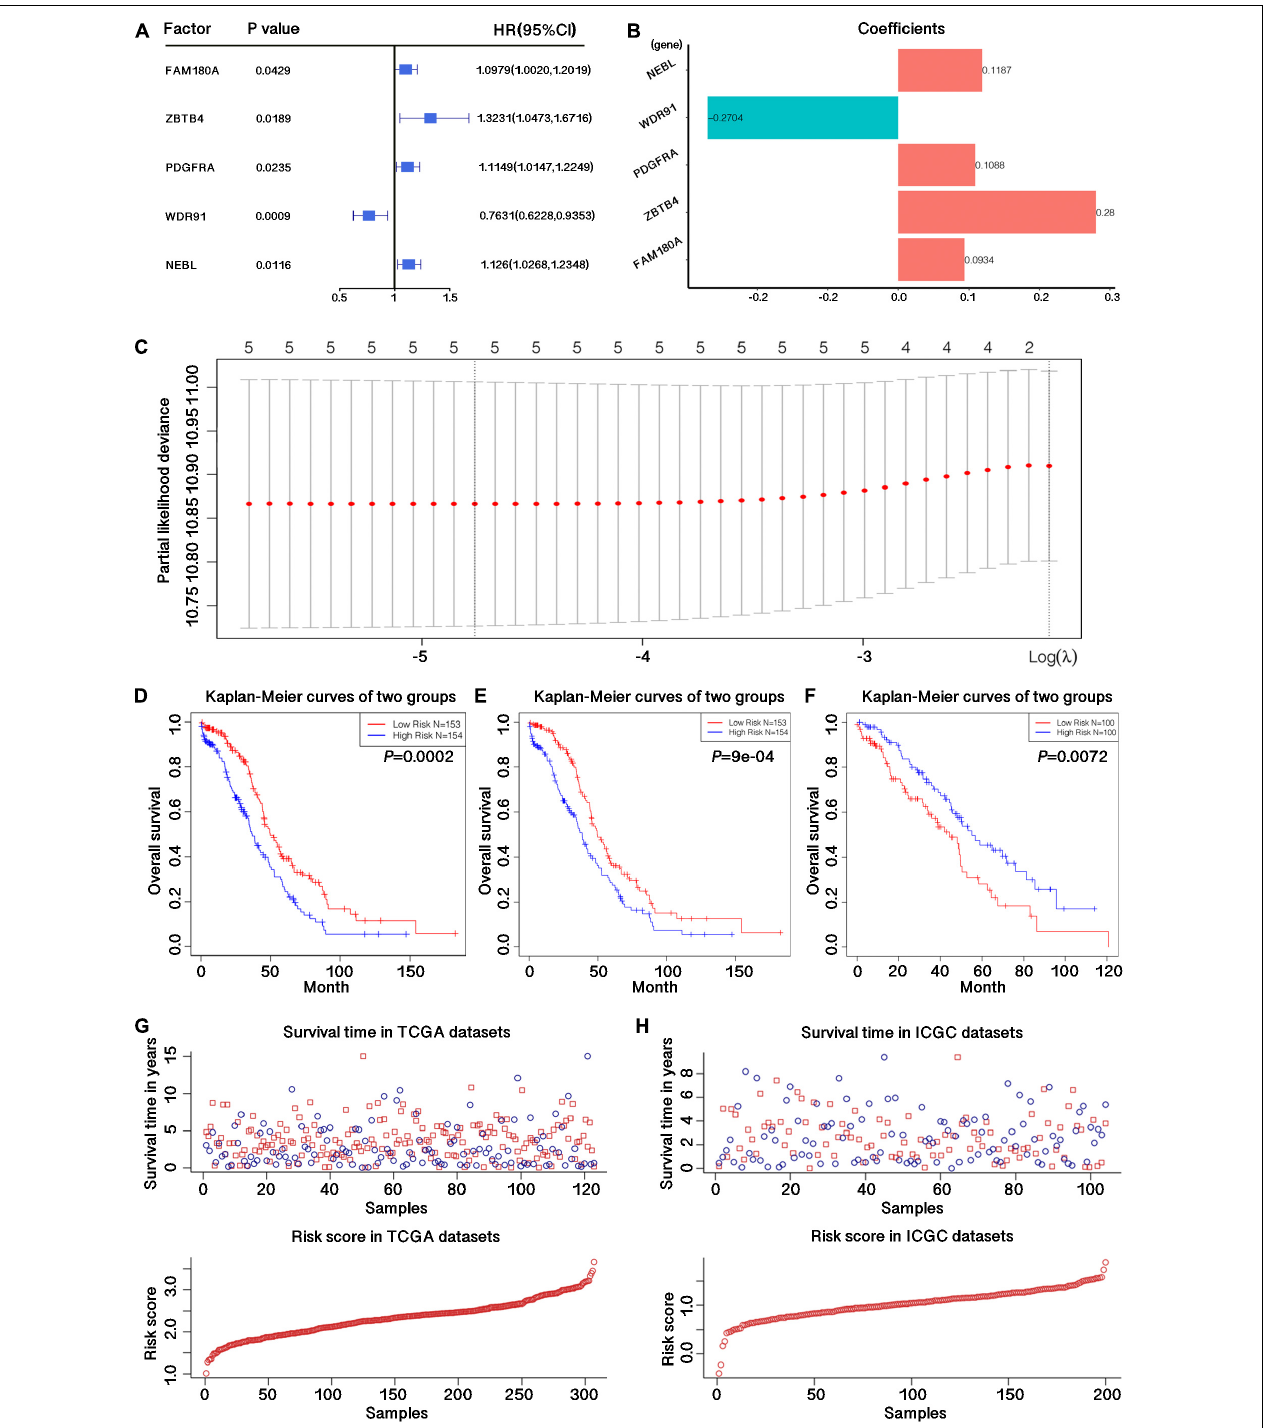
FIGURE 2 | Construction of the prognostic signature with four m 6 A-related genes. (A) p -value, Hazard Ratio value and confidence interval for all risk genes with potential independent prognostic efficacy obtained by univariate Cox regression analysis. (B) Regression coefficients of 5 m 6 A related genes obtained by univariate Cox regression analysis. (C) LASSO regression map of 5 m 6 A related genes. (D) Survival curve drawn by dividing the TCGA training datasets into high and low risk groups based on the risk score calculated by the feature matrix constructed from the 5 candidate m 6 A-related genes. (E) Survival curve drawn by dividing the TCGA training datasets into high and low risk groups based on the risk score calculated by the feature matrix constructed from the 4 candidate m 6 A-related genes. (F) Survival curve drawn by dividing the ICGC validation datasets into high and low risk groups based on the risk score calculated by the feature matrix constructed from the 4 candidate m 6 A-related genes. (G) Survival time and risk store in TCGA training datasets. (H) Survival time and risk store in ICGC validation datasets.